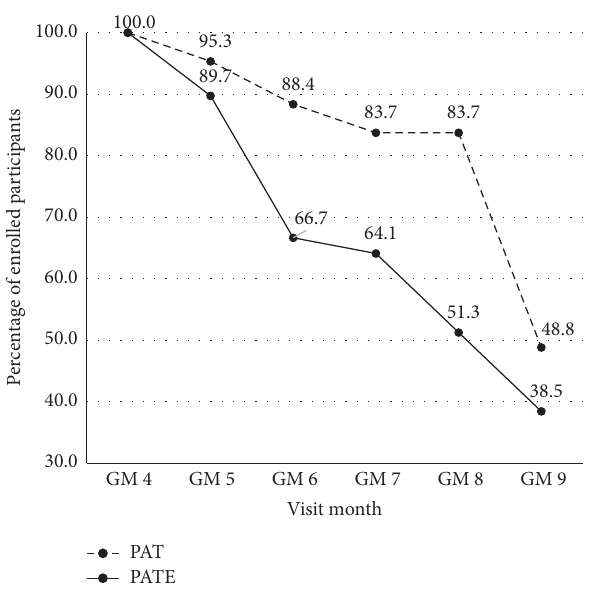
Figure 2: Delta Healthy Sprouts participant compliance rates in the gestational period by treatment